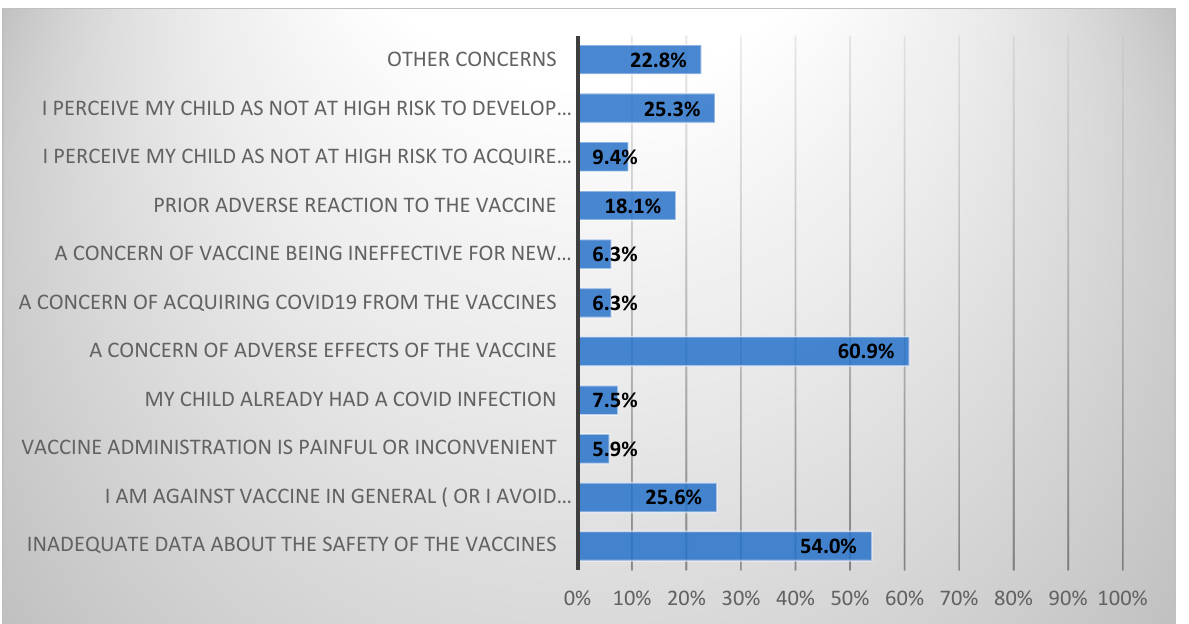
Figure A2. Parents’ reasoning for not giving their teenager children Booster COVID-19 vaccine. The most commonly reported reason for refusing a booster dose for their children (60.9%) was their belief the vaccines may have adverse effects followed by their perception of inadequate data on the safety of the vaccines (54%).